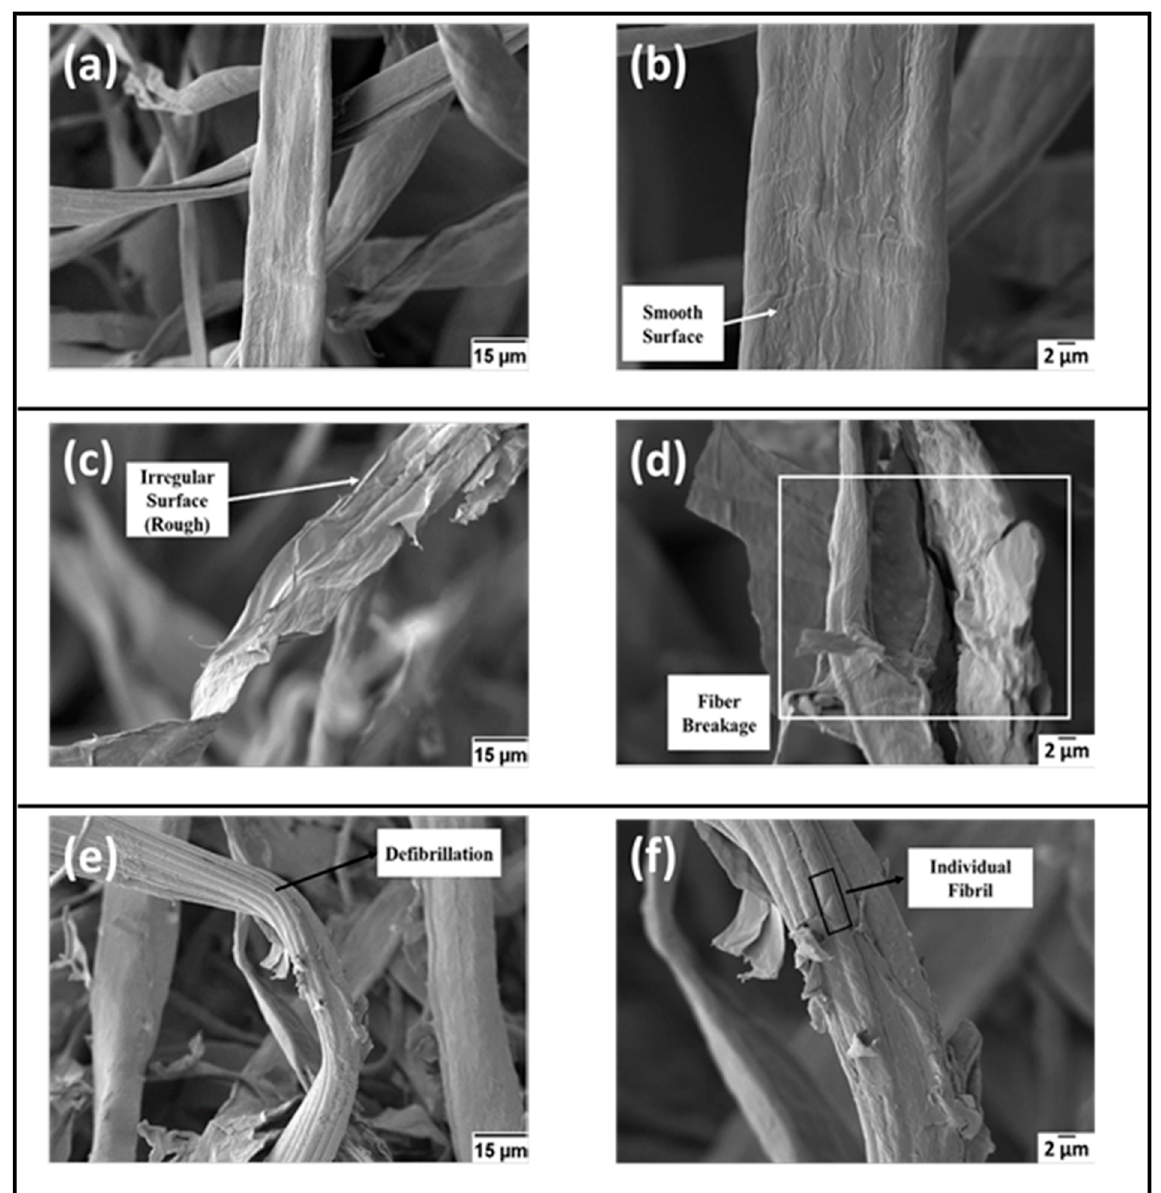
Figure 12. SEM Micrograph of ( a , b ) untreated, ( c , d ) alkali-treated, and ( e , f ) bleached waste cotton fibres [143] . In Figure 12a,b, the morphology of the untreated fibres indicated a smooth surface with predominance of fibre bundles. The effect of alkali hydrolysis affected the morphology of the fibre in Figure 12c,d. Very rough and irregular surfaces that include a breakage of fibre can be observed. This is attributed to the removal of the superficial layer, which was formed by wax [159]. After the bleaching of fibre, more expressive removal of amorphous contents was achieved. The removal of the amorphous region including hemicellulose and lignin resulted in the production of fibrils via fibrillation (Figure 12e,f). A well-structured superfine fibril of cotton fibers consisting of high cellulose content is an ideal precursor for the extraction of CNC. An observable trend of residue weight decreases as a result of the progression of chemical treatment noticed, suggesting that the effect of alkali and bleaching treatment on the cotton fibres effectively removed the amorphous content and other impurities. This process is very significant due to the effect of the components on the crystallinity and thermal stability of the extracted CNC. A summary of the extraction processes of CNCs derived from cotton wastes is presented in Figure